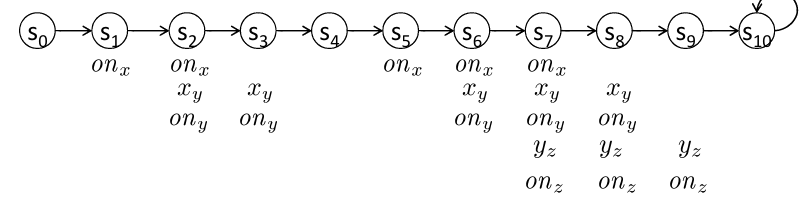
Figure 5: State transition system corresponding to Fig.